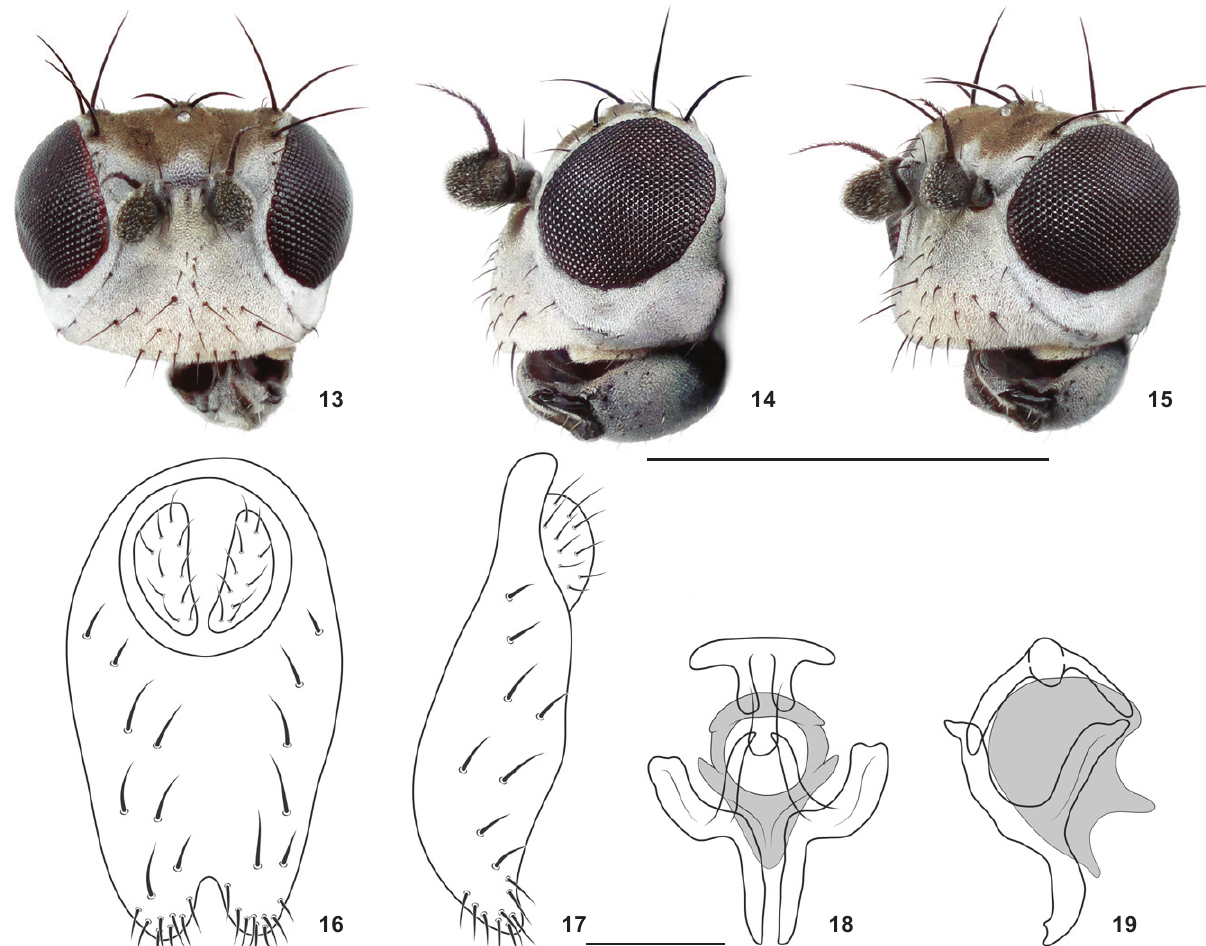
Figures 13-19. Scatophila darrowae sp. nov. , Brazil, Paraná: Bocaiúva do Sul: (13) head, anterior view; (14) same, lateral view; (15) same, oblique view; (16) epandrium and cercus, posterior view; (17) same, lateral view; (18) aedeagus, gonite, neohypandrium, phallapodeme, ventral view; (19) same, lateral view. Scale bars: 13-15 = 0.5 mm, 16-19 = 0.1